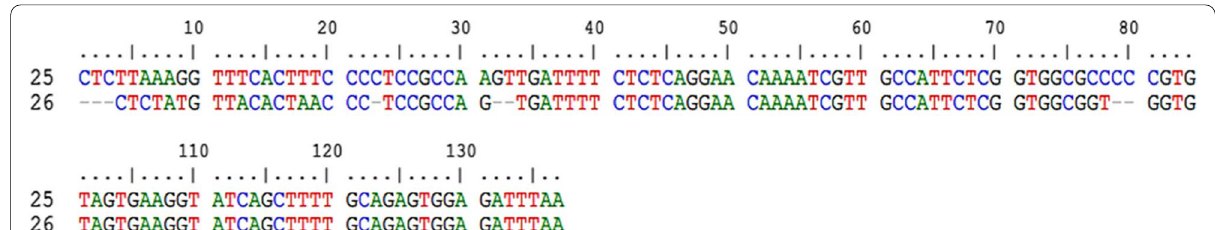
Fig. 7. Alignment of two sequences of the monomorph alleles of CAC15